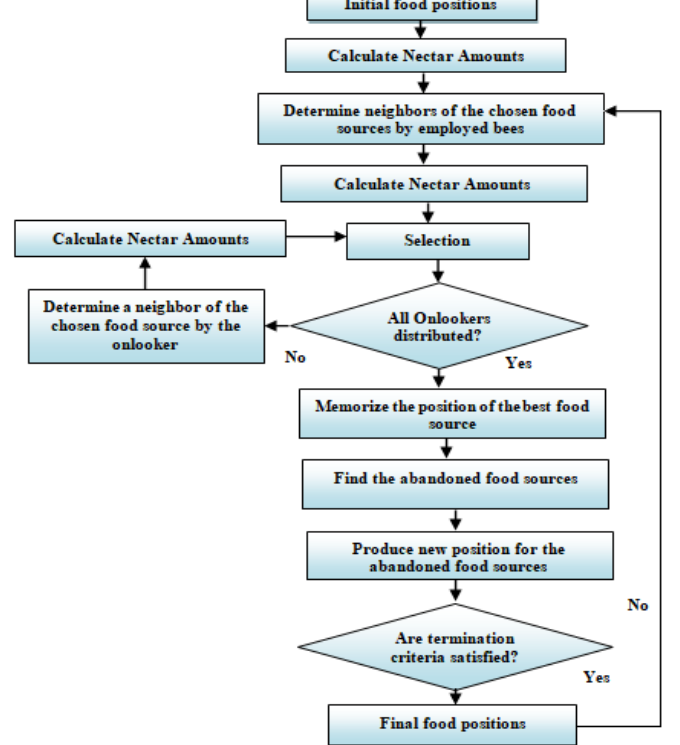
Figure 6. Working flow of ABC.